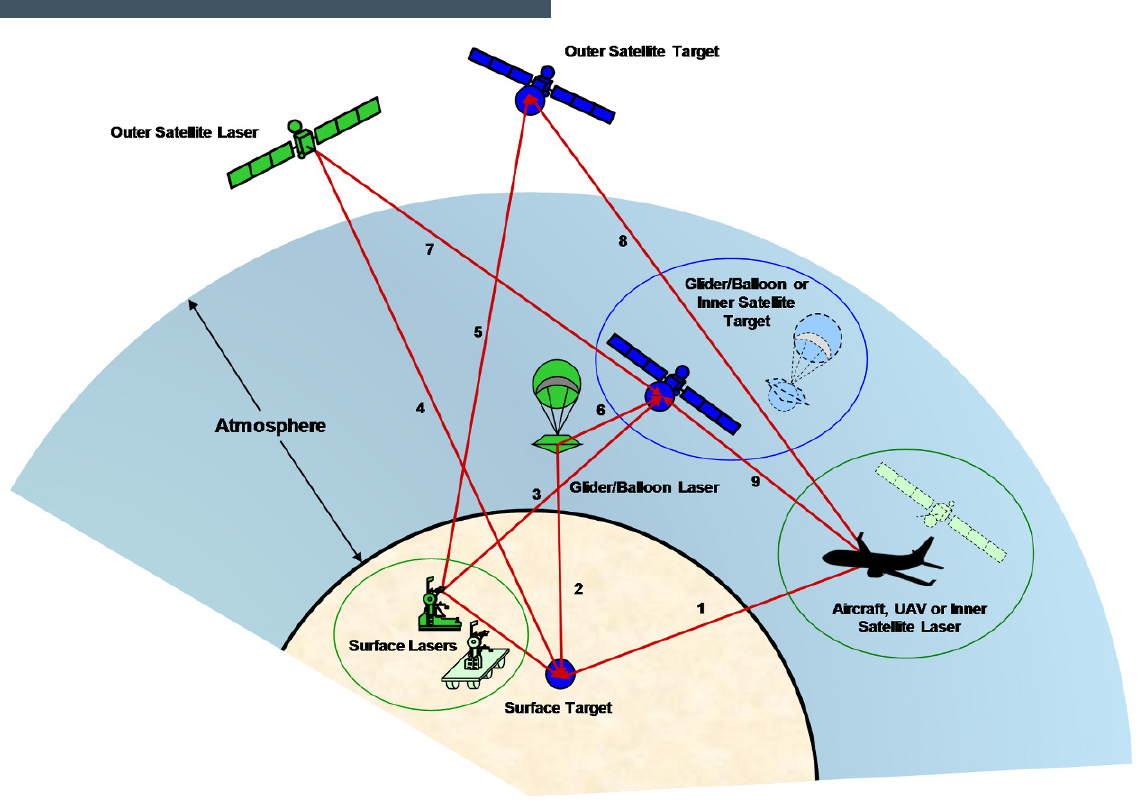
Figure 1. Possible platform